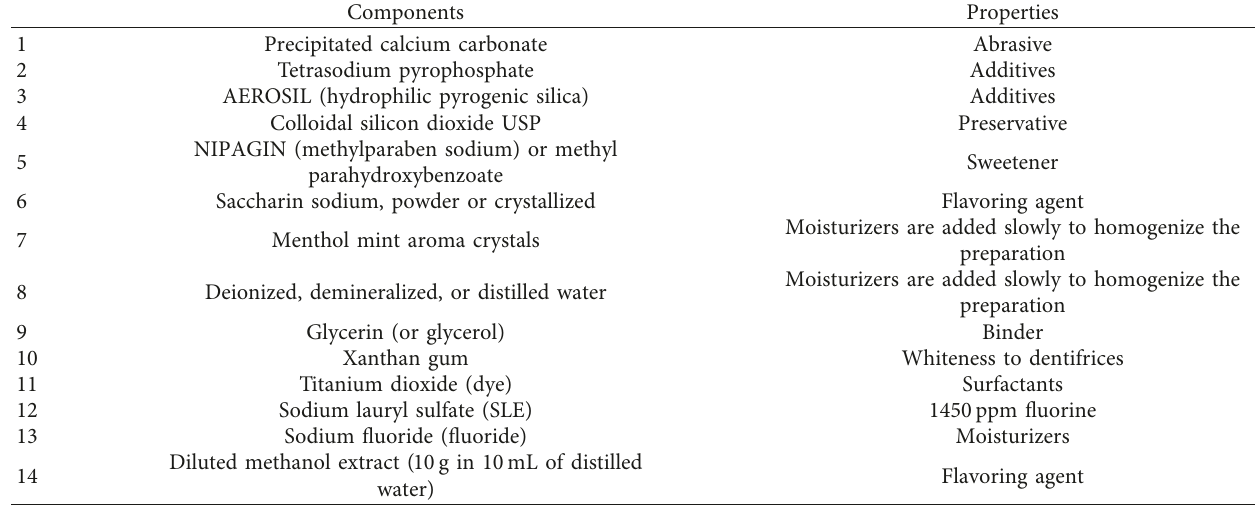
Table 1: Chemical components of experimental dentifrice based on Passiflora mollisima